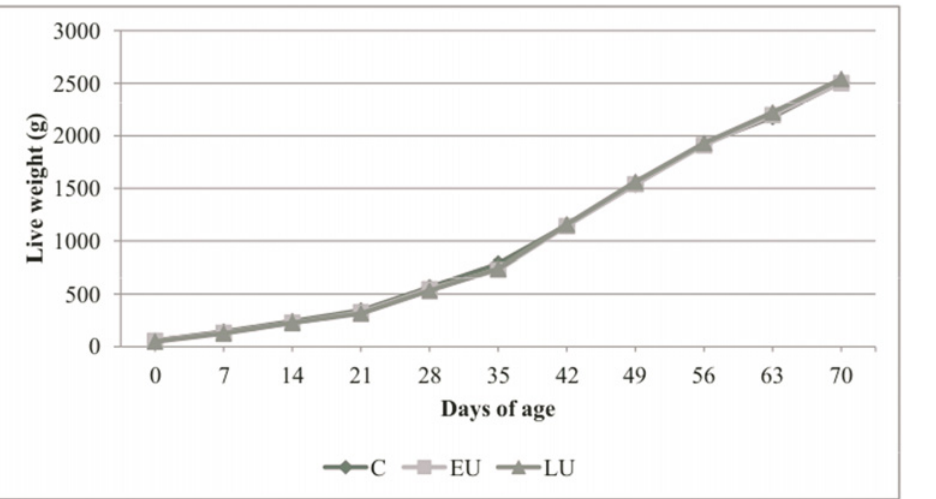
Fig 2. Effect of gestational maternal undernutrition on live weight (g) of rabbit offsprings from 0 to 70 days of age. C = rabbits born from does fed to 100% of maintenance energy requirements; EU = rabbits born from does fed to 50% of maintenance energy requirements from day 7 to day19 of gestation; LU = rabbits born from does fed to 50% of maintenance energy requirements from day 20 to day27 of gestation (n = 16). (Individual s.e. lines are present but not visible due to scale range).